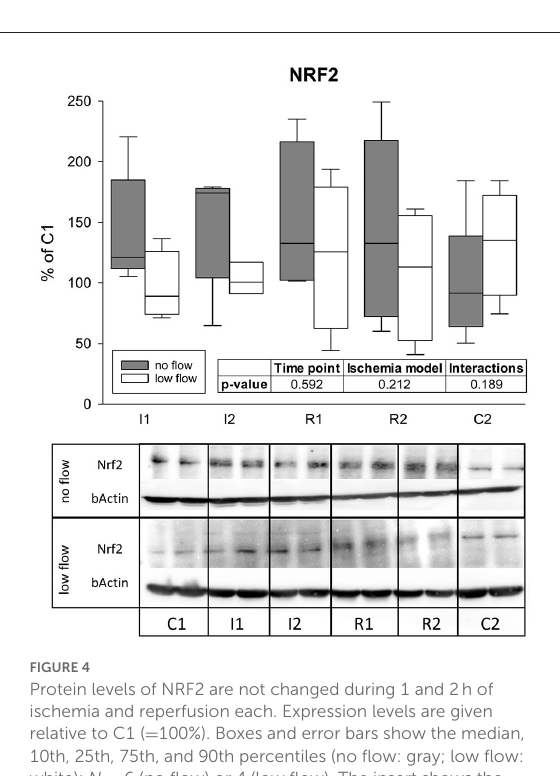
FIGURE4 Protein levels of NRF2 are not changed during 1 and 2h of ischemia and reperfusion each. Expression levels are given relative to C1 ( = 100%). Boxes and error bars show the median, 10th, 25th, 75th, and 90th percentiles (no flow: gray; low flow: white); N = 6 (no flow) or 4 (low flow). The insert shows the result ( p -values) of the statistical analysis using a two-way RM ANOVA. Representative blots are shown below.